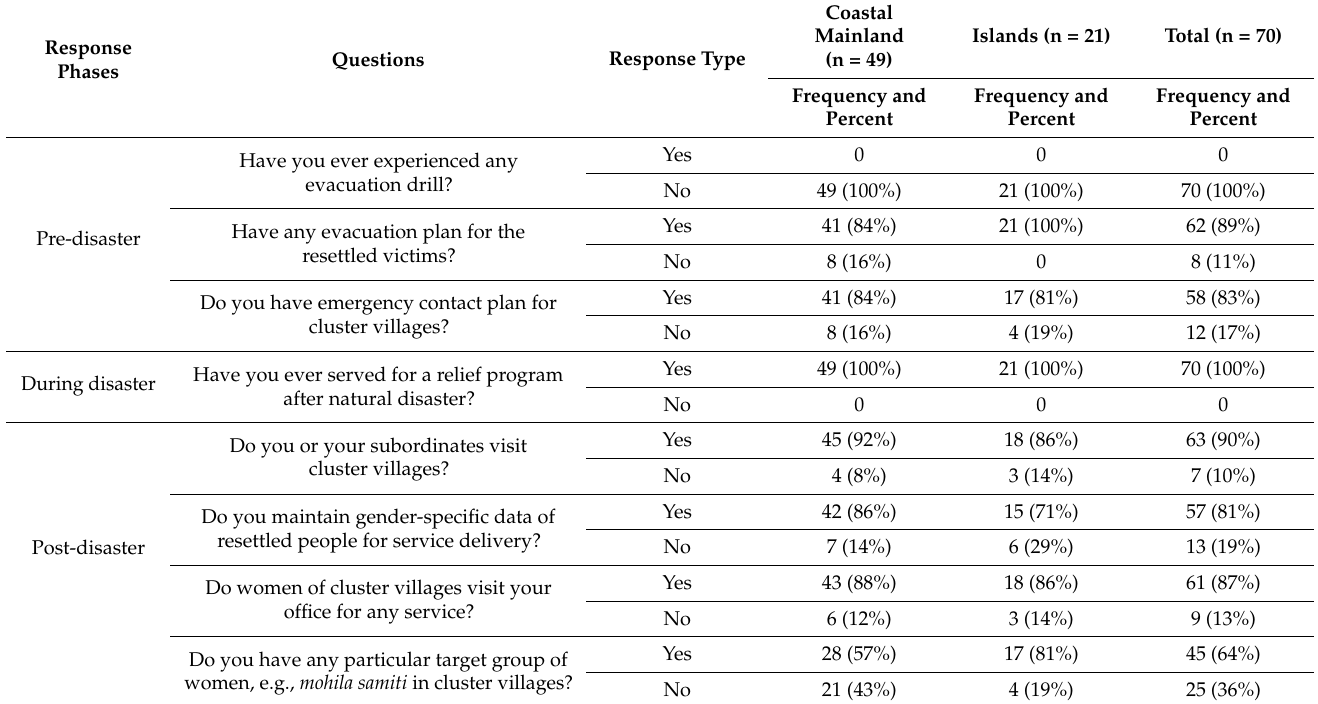
Table 2. The respondents’ engagement in climatic-induced disaster response